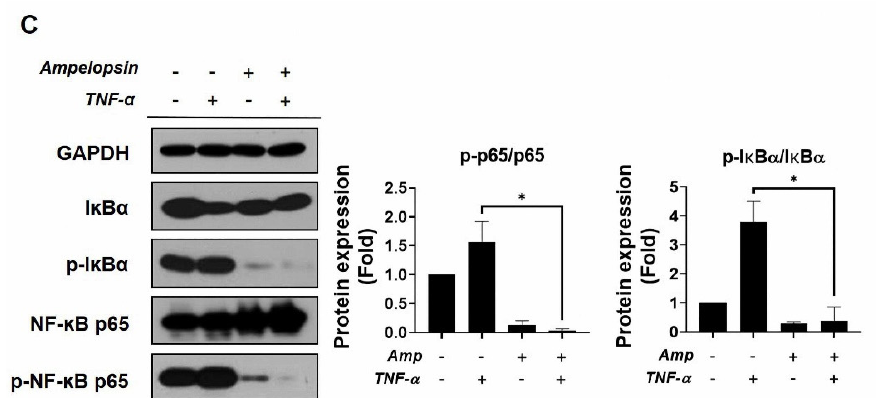
Figure 5. NF- κ B inhibition by ampelopsin was determined in MDA-MB-231/IR cells. Representative results of Western blotting indicating ( A ) the levels of I κ B α , p-I κ B α , NF- κ B p65, and p-NF- κ B p65 in MDA-MB-231 and MDA-MB-231/IR cells. Original films were shown in Figure S7; ( B ) the levels of I κ B α , p-I κ B α , NF- κ B p65, and p-NF- κ B p65 in MDA-MB-231/IR cells after 24 h treatment with ampelopsin. Original films were shown in Figure S8; and ( C ) the effects of ampelopsin on the TNF- α -stimulated NF- κ B activity. In this experiment, cells were pretreated with 100 µM ampelopsin before exposure to 10 ng/mL TNF- α for 12 h. Original films were shown in Figure S9. GAPDH was used as the loading control. * p < 0.05 vs. control.